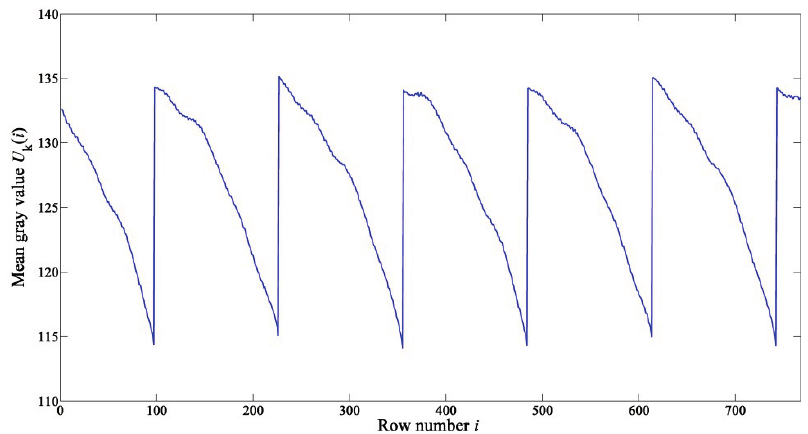
Figure 6. Mean gray value versus i .